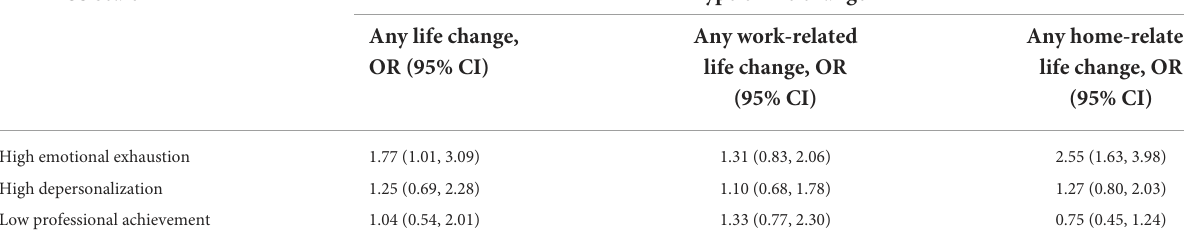
TABLE 4 Unadjusted odds ratios (OR) of burnout associated with life changes due to COVID-19. MBI-HSS scale